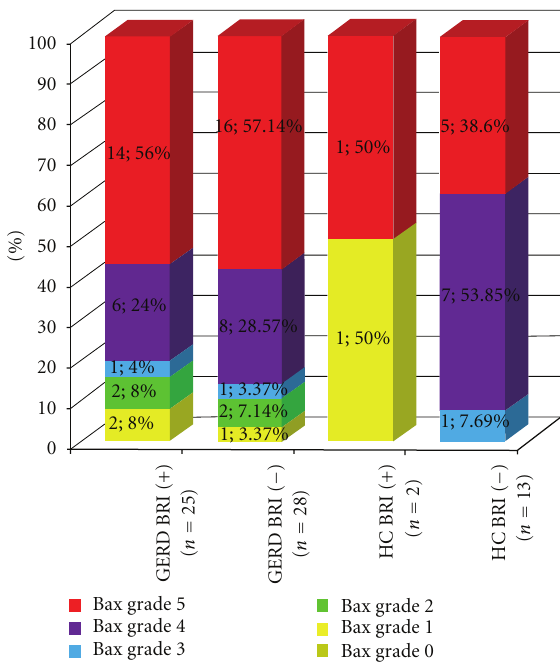
Figure 1: Bax expression in gastric mucosa in healthy controls (HCs) and GERD patients, in relation to BRI status. Grouped data are presented in 100% display stacked columns for each grade ( n ; %). According to the percentages of the stained epithelial cells, the immunohistological sections were scored and graded as follows: 0 = absence of staining, 1 = staining up to 5%, 2 = staining > 5%–10%, 3 = staining > 10%–25%, 4 = staining > 25%–50%, and 5 = staining >